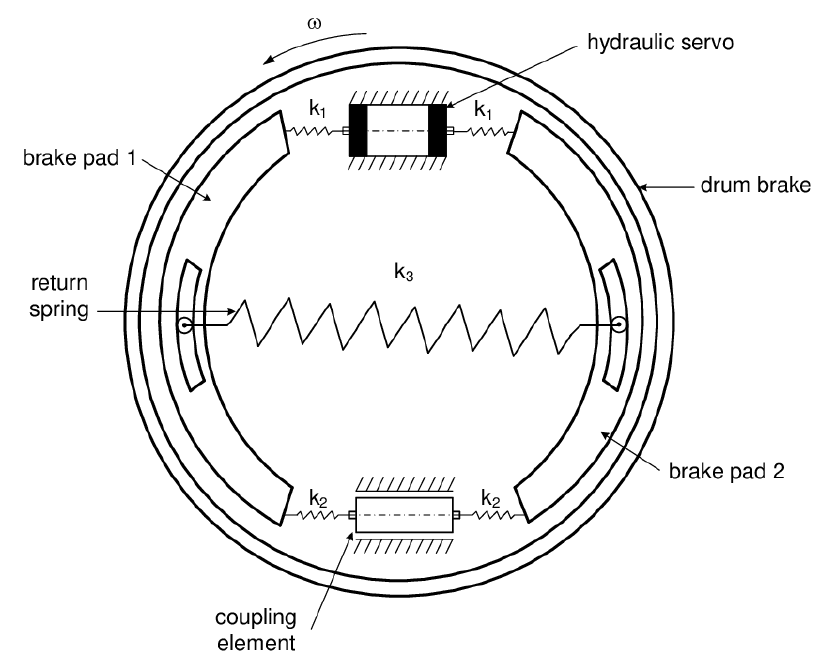
Figure 2 Drawing of a ‘duo-servo’ Girling brake